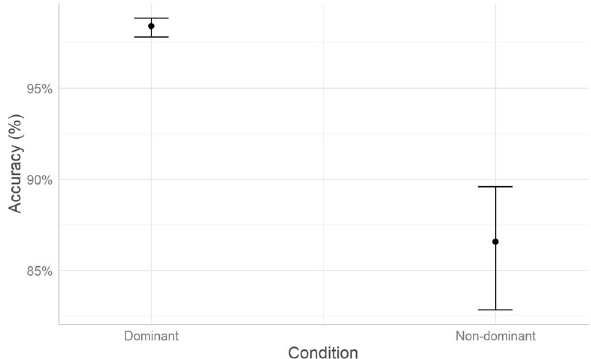
Figure 2. Predicted effect of Condition on Accuracy (n trials = 6,359, n ADHD = 17, n TD = 26, estimated marginal means with whiskers representing 95% confidence